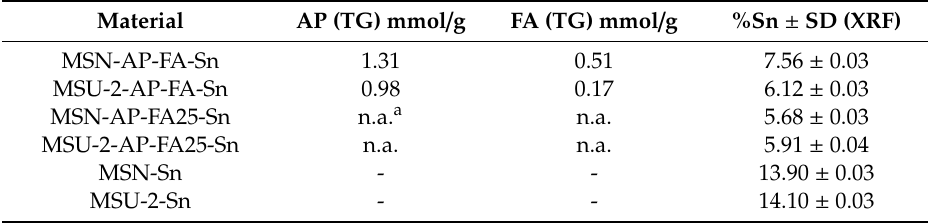
Table 2. Functionalization rates for some of the studied materials determined by TG or XRF.